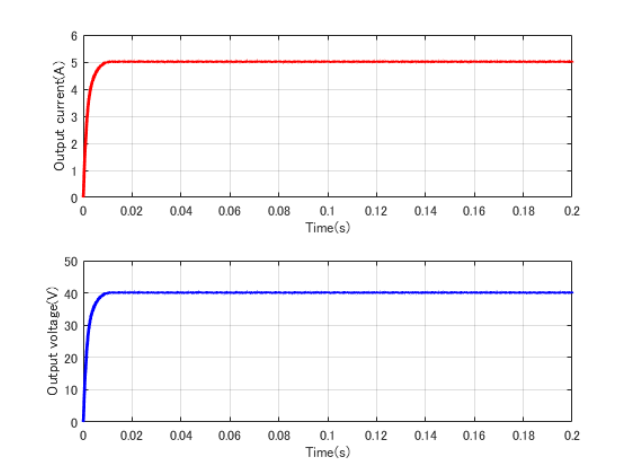
Figure 15. Output voltage and current